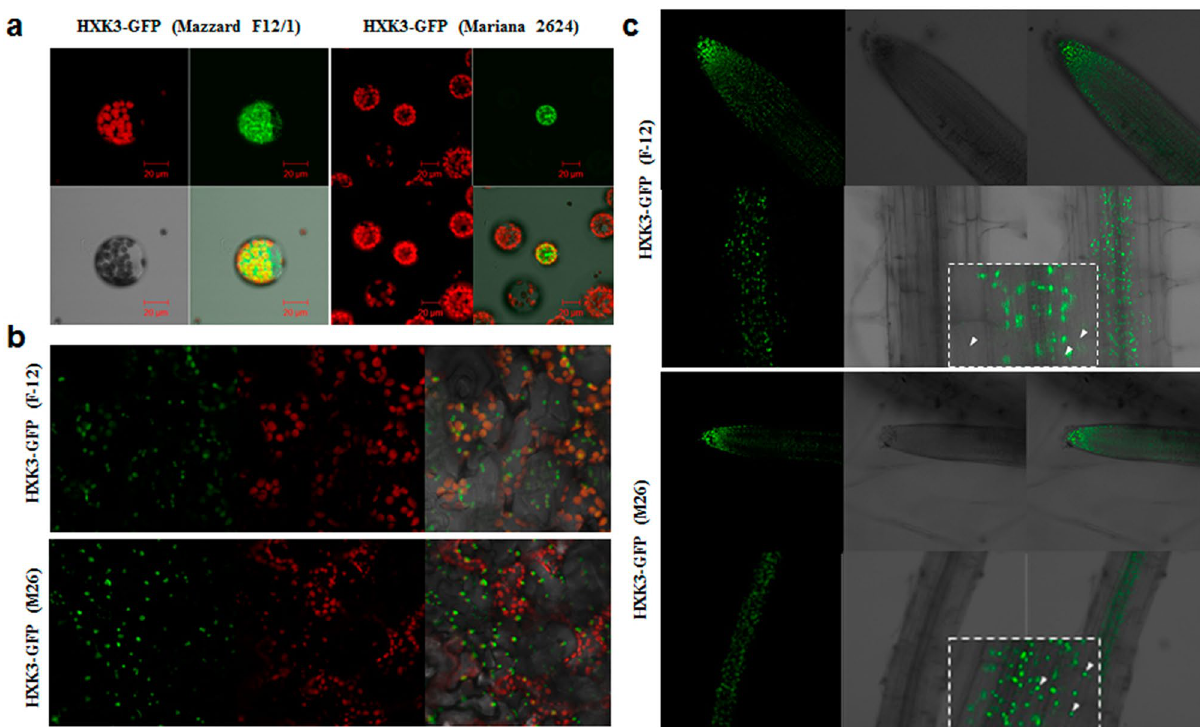
Figure 3. Subcellular localization of Prunus HXK3-GFP proteins. ( a ) Transient expression in Arabidopsis thaliana protoplasts. ( b ) Stable expression in Arabidopsis leaves. ( c ) Stable expression in Arabidopsis roots. Cells rich in chloroplast as epidermal pavement and mesophyll cells were detected by chlorophyll fluorescence (red) and HXK3-GFP was detected by green fluorescence. After transformation, the samples were incubated for 24 h at 22 °C (Arabidopsis protoplasts). The samples were visualized by confocal microscope. The experiments were done in triplicate, resulting with the same fluorescence